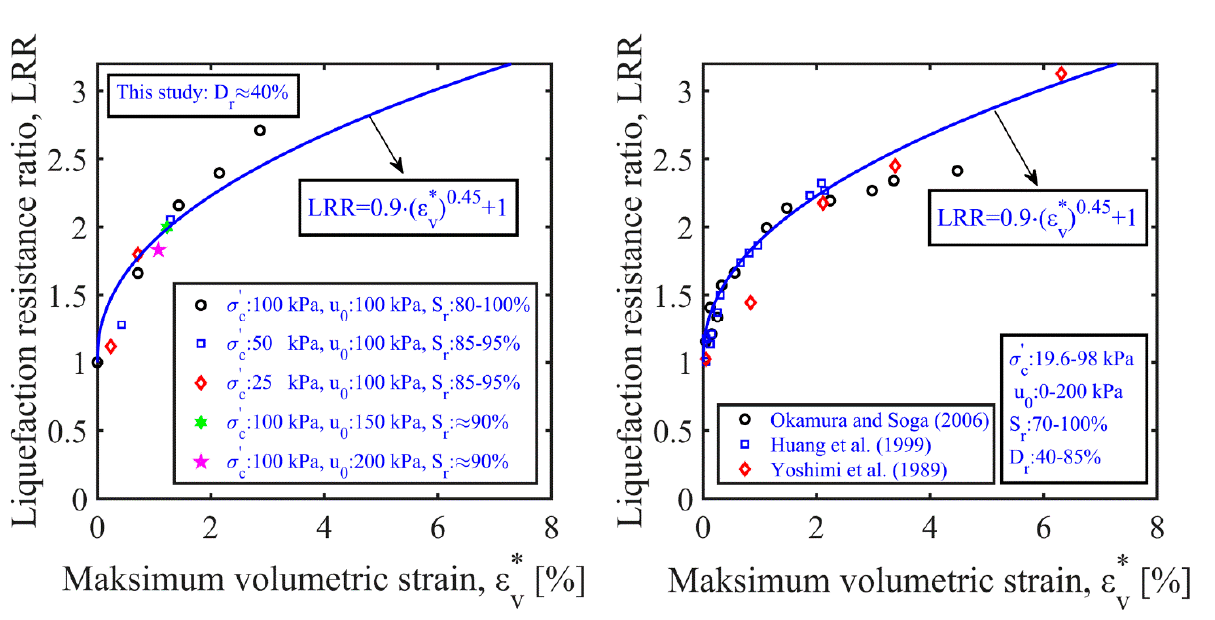
Figure 14. Variation in liquefaction-resistance ratio with maximum volumetric strain [17,35,36]. In this equation, the positive exponent (namely, 0.45) indicates the growth of the liquefaction-resistance ratio ( LRR ) with an increase in the normalized potential volumetric strains ( ε ∗ ). The amplitude of the increase in the liquefaction-resistance ratio with increasing v normalized potential volumetric strains is characterized by a scaling factor of 0.9. As the exponent is smaller than 1, the slope of the curve is expected to continuously